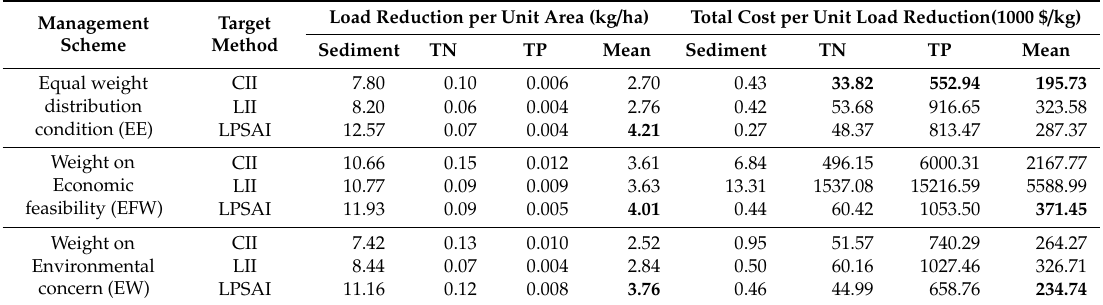
Table 9. Monthly pollutant load reduction per unit area (kg / ha) and total cost per unit pollutant load reduction ($1000 / kg) associated with di ff erent management schemes (EE, EFW, and